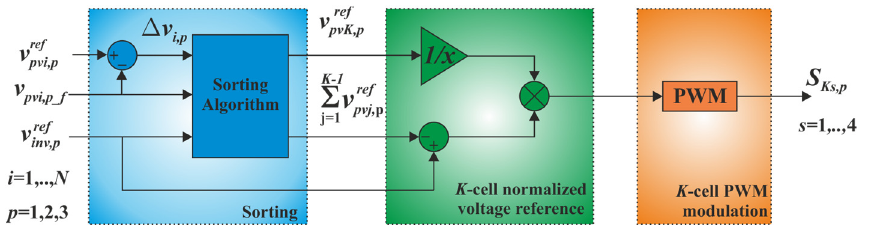
Figure 4. Sorting algorithm.